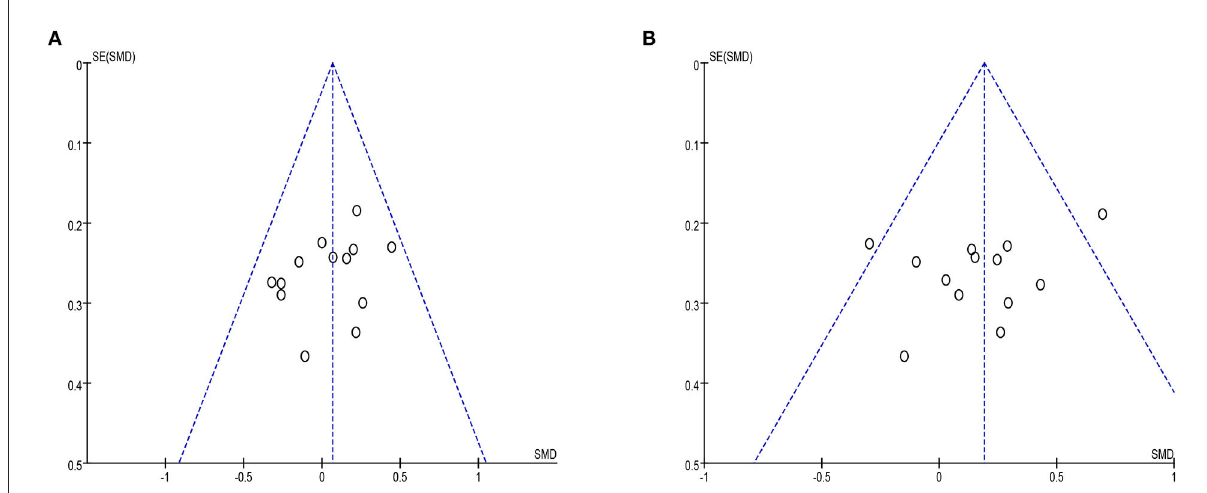
FIGURE12 (A) The VAS funel plot included in the study. (B) The ODI funel plot included in the